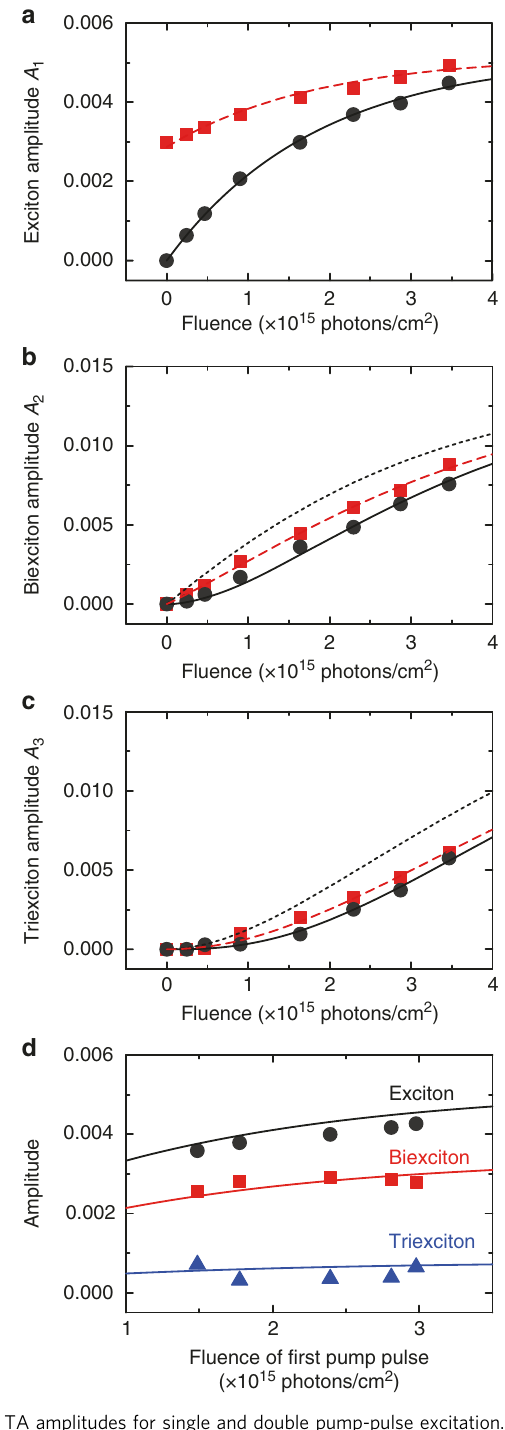
Fig. 3 TA amplitudes for single and double pump-pulse excitation. a – c TA amplitudes of a single excitons, b biexcitons, and c triexcitons. The fi tting results of these amplitudes for single and double pump-pulse excitation are plotted by the black fi lled circles and red fi lled squares, respectively. The calculated results for the single pump-pulse experiments are shown by the black solid curves. The calculated results for the double pump-pulse experiments under the assumptions of identical and variable absorption cross-sections are shown by the black dotted and red dashed curves, respectively. d Dependence of TA amplitudes on the fi rst pump-pulse fl uence for double pump-pulse excitation. The solid curves are